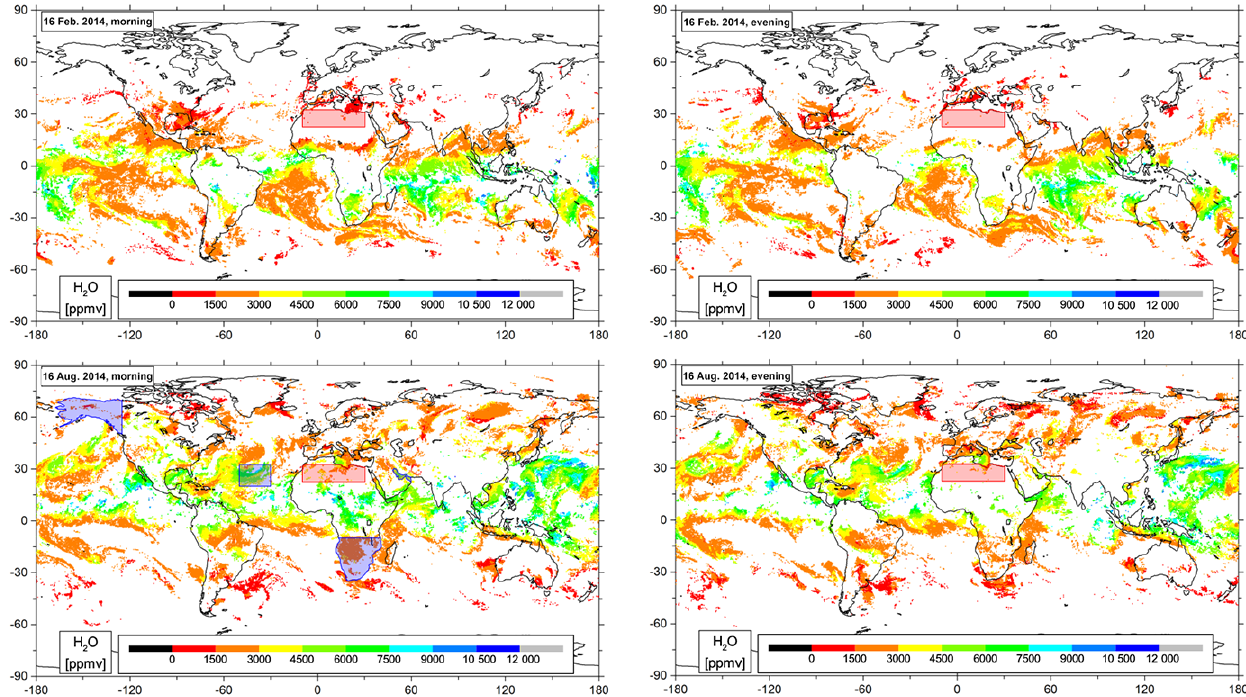
Figure 9. Daily morning and evening coverage for the MUSICA IASI-A and IASI-B Type 2 retrieval product that passed the sensitivity filter (Eq. 5) for 4.9km altitude and the retrieval quality filter. Left panels show the morning overpass and the right panels show the corresponding evening overpass. Top panels are for a typical situation during northern winter (example 16 February 2014) and bottom panels for northern summer (example 16 August 2014). The marked areas (blueish and reddish) are discussed in detail in the context of Fig.